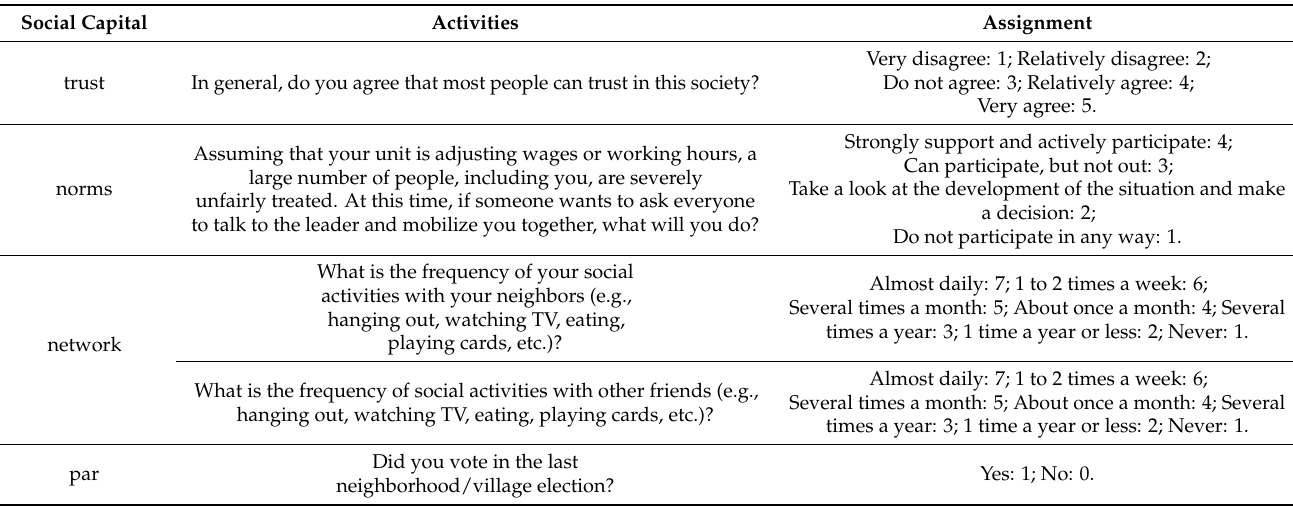
Table 3. Social capital measurement